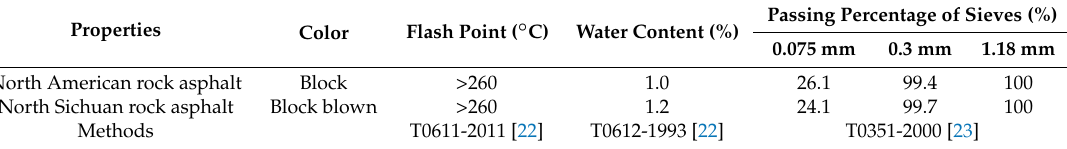
Table 1. Rock asphalt properties.